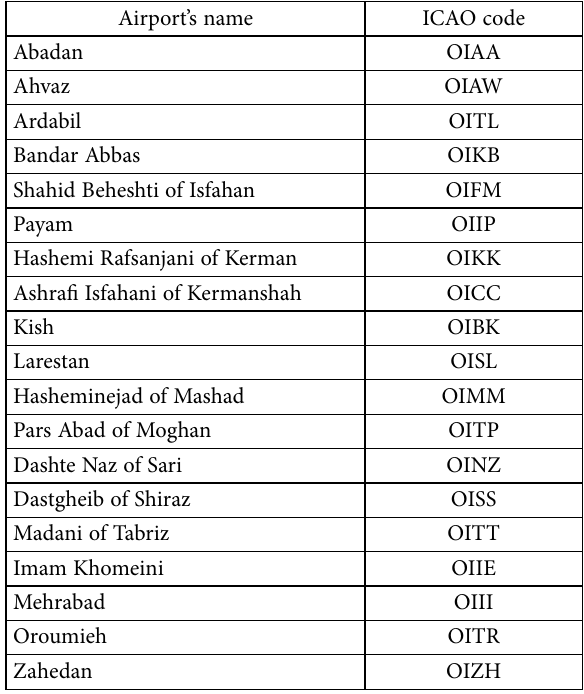
Table 5. The list of Iranian international airports